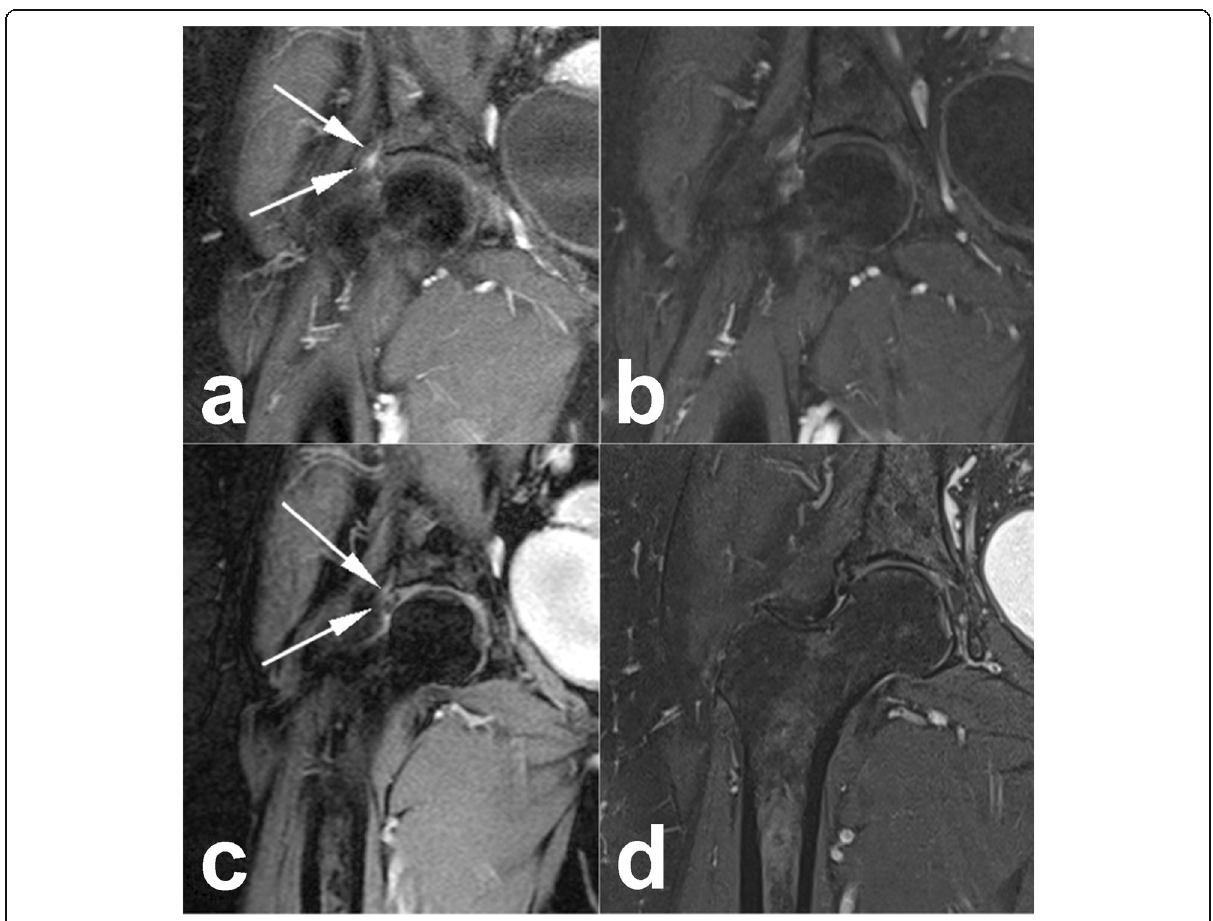
Fig. 1 Coronal Magnetic Resonance image of the right hip joint. a and b pre and post embolization DPW-weighted image with adipose tissue saturation. c and d pre and post embolization Post-contrast T1W-weighted image with tissue saturation. In ( a and c ) note a degeneration in the superolateral segment of the acetabular labrum with mild pericapsular edema and post-contrast enhancement (arrows). In the four- month post- procedure image, the pericapsular edema was almost completely resolved ( b ), and a partial resolution of post-pericapsular contrast enhancement ( d